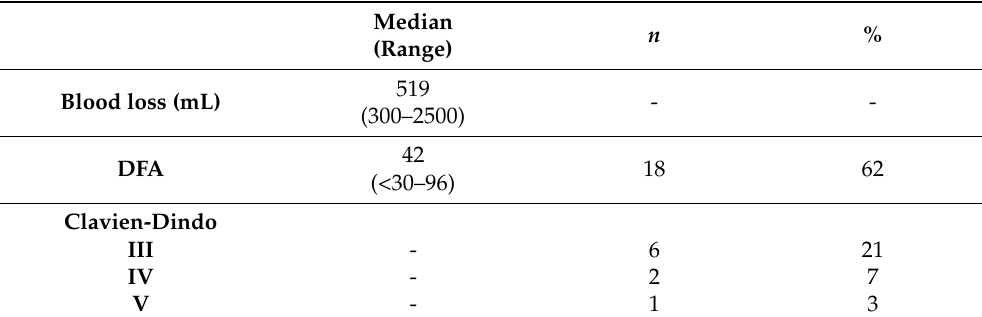
Table 3. Intra-operative and post-operative complications occurring in patients undergoing pancreatic resection following Table 3. Intra ‐ operative and post ‐ operative complications occurring in patients undergoing pancre ‐ atic resection following NCR.